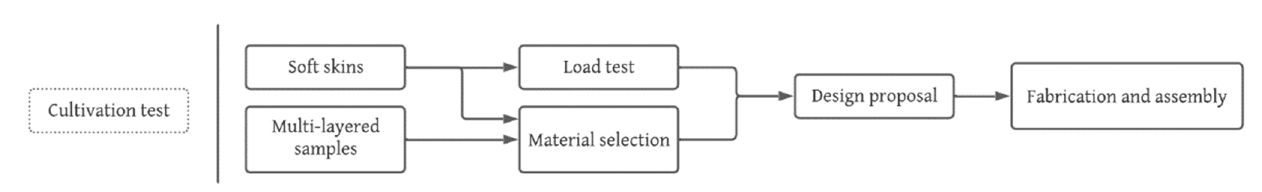
Figure 2. Bottom-Up workflow diagram.